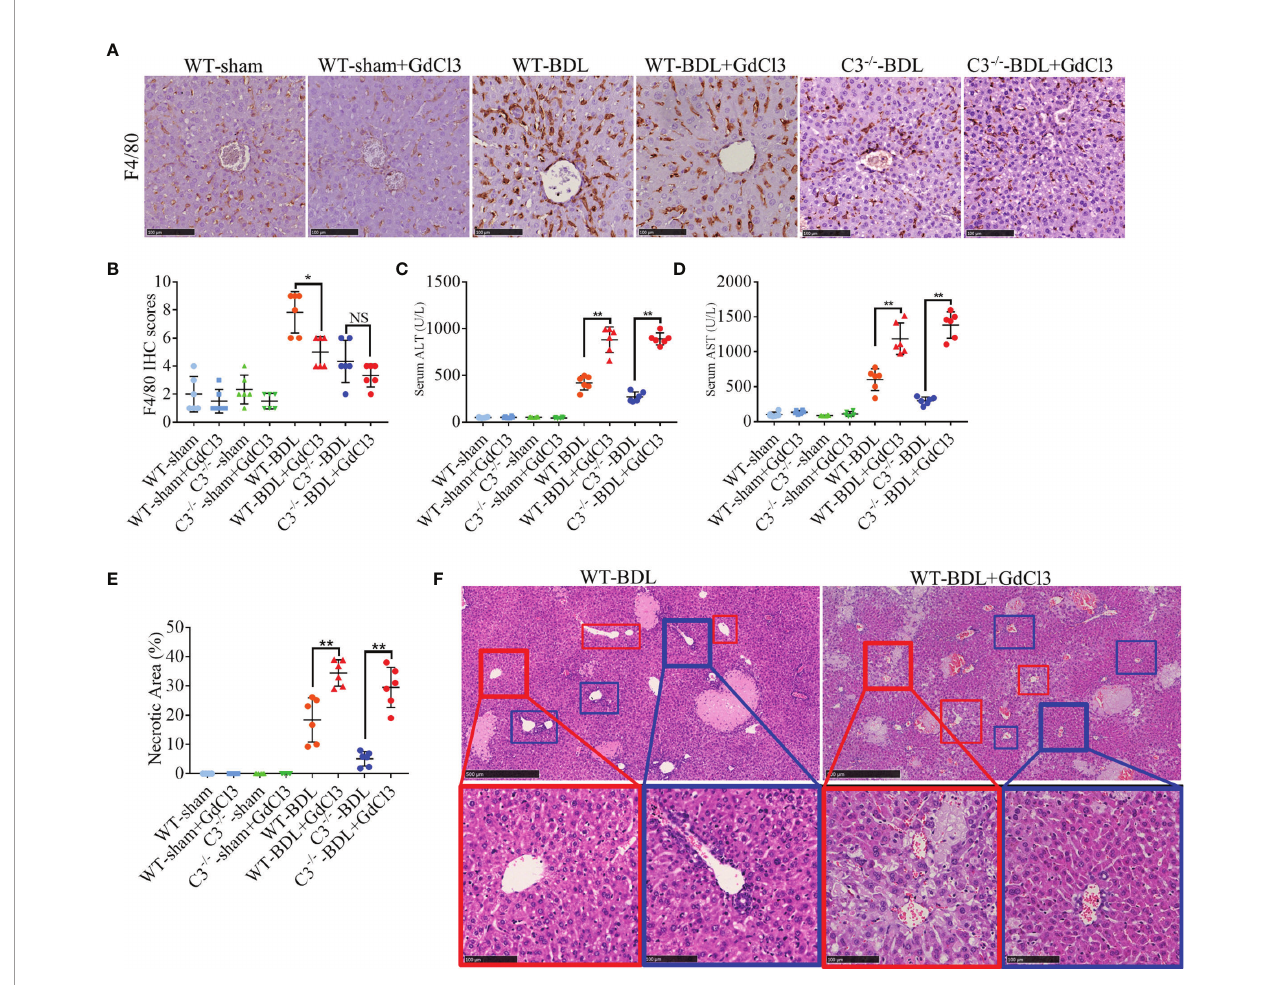
FIGURE 5 | GdCl3 inhibition of macrophages exacerbates CLI in mice. Wild-type and C3 de fi cient mice were subjected to BDL or sham operations. The mice were injected i.v. with PBS or GdCl3 and sacri fi ced after 3 days. (A, B) F4/80 immunostaining (scale bars: 100 m m; n = 6 per group). (C, D) Serum concentrations of (C) ALT and (D) AST (n = 6 per group). (E) Assessment of liver necrosis (n = 6 per group). (F) HE staining (red boxes, central venous areas; blue boxes, portal areas; scale bars, 500 m m for upper images, 100 m m for lower images). Results are expressed as mean ± SD. *p < 0.05, **p < 0.01; NS, not signi fi